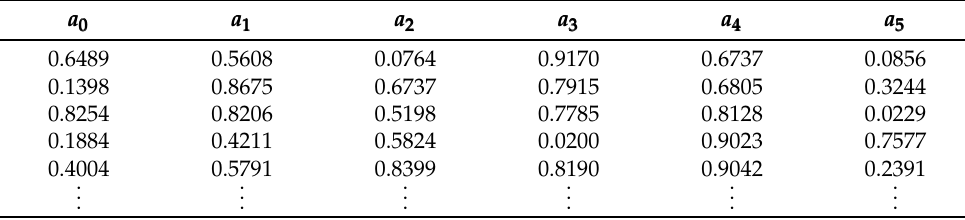
Table A1. Head of the input data set for training the ANN 5 for computing both real and